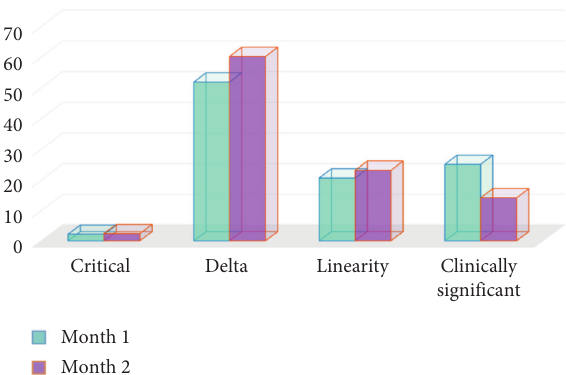
Figure 4: The distribution of different causes of repeat testing over two consecutive months in